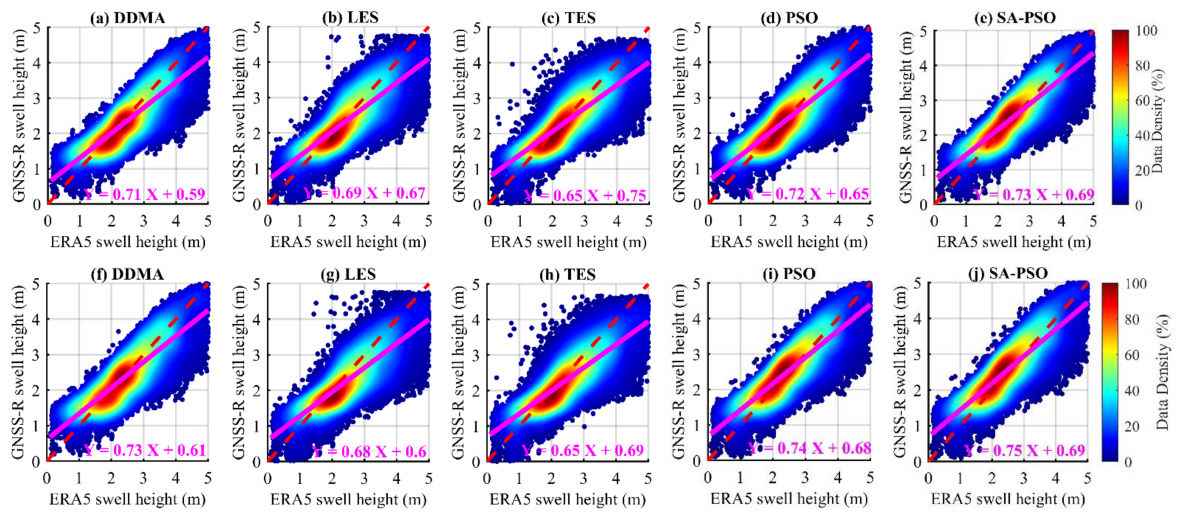
Figure 8. Scatter density plots of CY01 and CY02 swell height estimates and ERA5 swell height data. The color bars show data density in relation to the distribution peak (from cool to warm). The dotted line in red represents the 1:1 reference line, whereas the magenta solid line represents the linear fitting results of GNSS-R swell height estimations and ERA5 swell height data. The results of CY01 based on ( a ) DDMA, ( b ) LES, ( c ) TES, ( d ) PSO, and ( e ) SA-PSO. The results of CY02 based on ( f ) DDMA, ( g ) LES, ( h ) TES, ( i ) PSO, and ( j ) SA-PSO.